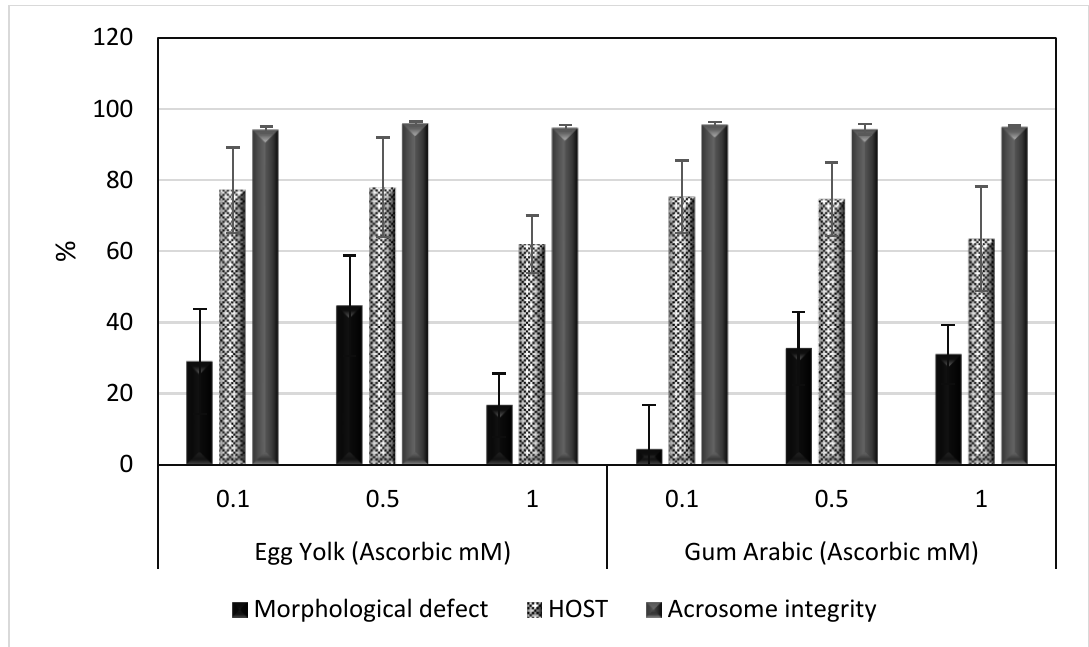
Figure 4. Mean ± SEM of morphological defects, HOST and acrosome integrity of spermatozoa in egg yolk or gum arabic extenders supplemented with different concentrations of ascorbic acid (0.1, 0.5 and 1 mM) and stored by deep freezing at − 196 ◦ C. HOST: hypoosmotic swelling